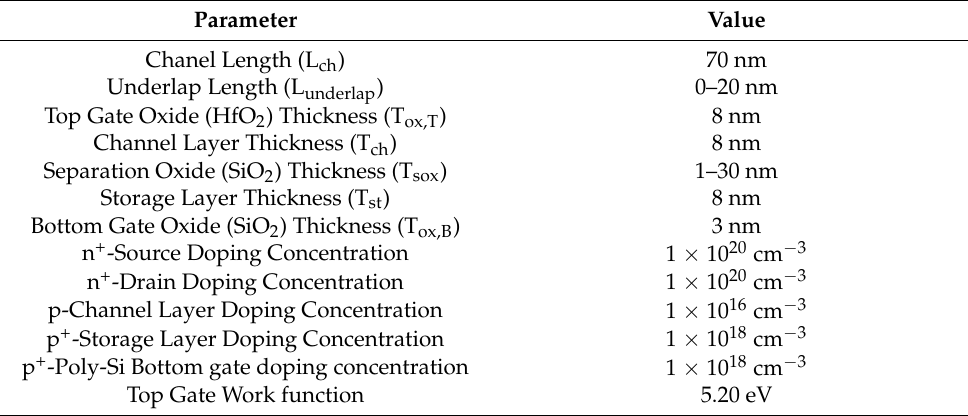
Figure 1. Poly-Si based 1T-DRAM with storage layer separated using separation oxide. Table 1. Parameters for the proposed